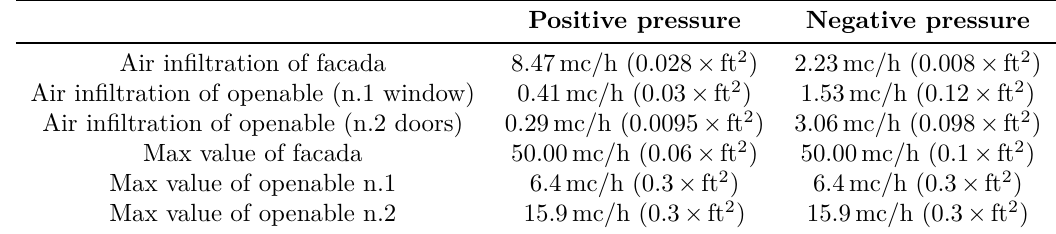
Table 2. Air infiltration test for the mock-up 02 in positive and negative